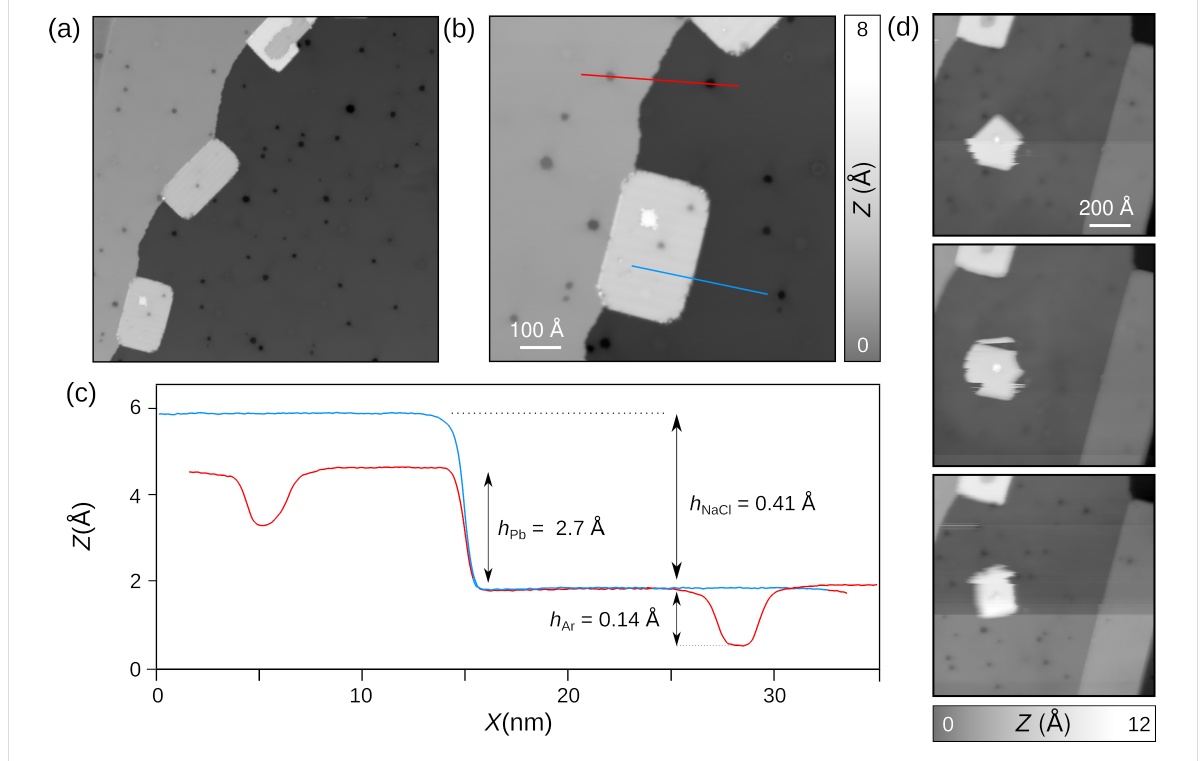
Figure 3: Adsorption of NaCl on Pb(111). (a, b) STM overview image of Pb(111) with quadratic NaCl islands adsorbed at step edges ( V t = − 0.4 V, I t = 1 pA). (c) Height profile extracted along the red and blue lines of panel (b). (d) Series of STM image showing the tip-induced rotation of an NaCl island ( V t = − 0.4 V, I t = 40